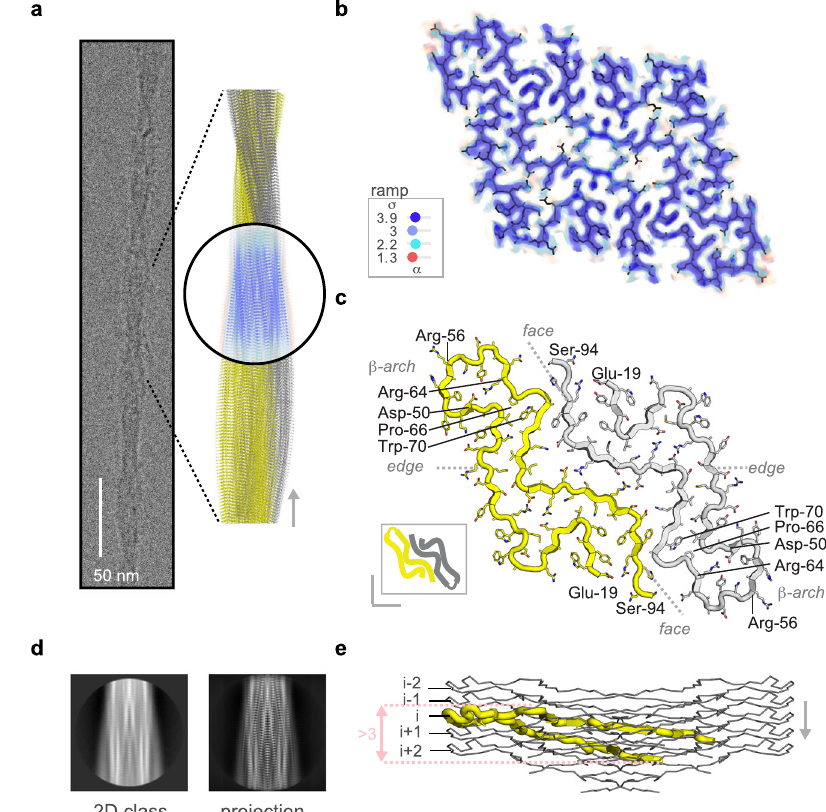
Fig.2|The3.3Åresolutioncryo-EMstructureofcatAAamyloidextracted post mortem from the kidney. a Cryo-EM image of a single straight fi bril with a cross- over distance in the 650 – 700Å range. The fi bril model spans approximately an entire crossover length of 680Å and was constructed using the deposited model (PDB: 7ZH7) composed of two proto- fi laments (yellow and gray), each assembled by fi ve chains. The map view was oriented to match the fi bril orientation of the averaged 2D class and corresponding 2D projection of the reconstructed map. Comparedtothecolorrampinpanel b ,mapvaluesweresetto1.1,2.0,4.4and14.2 for better visualization of inter-chain distances. b Cross-sectional view of the map volume with contour levels according to the depicted σ -color scale. c The mole- chains in yellow and gray. N- and C-terminal positions of each chain and of the β